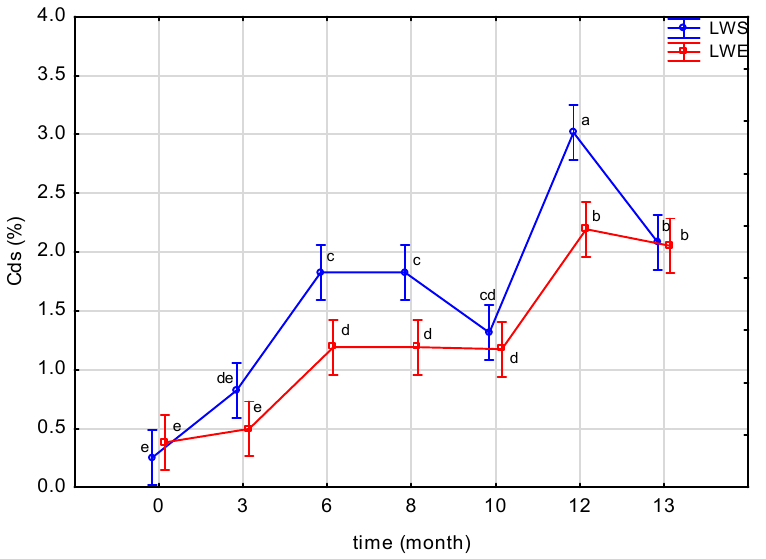
Figure 3. Conjugated diene concentration (CD) of standard wafers (LWS) and wafers with extract (LWE) during 13 months of storage. Vertical bars indicate 0.95 confidence intervals, the same letters indicate a lack of significant differences between data ( α = 0.05).